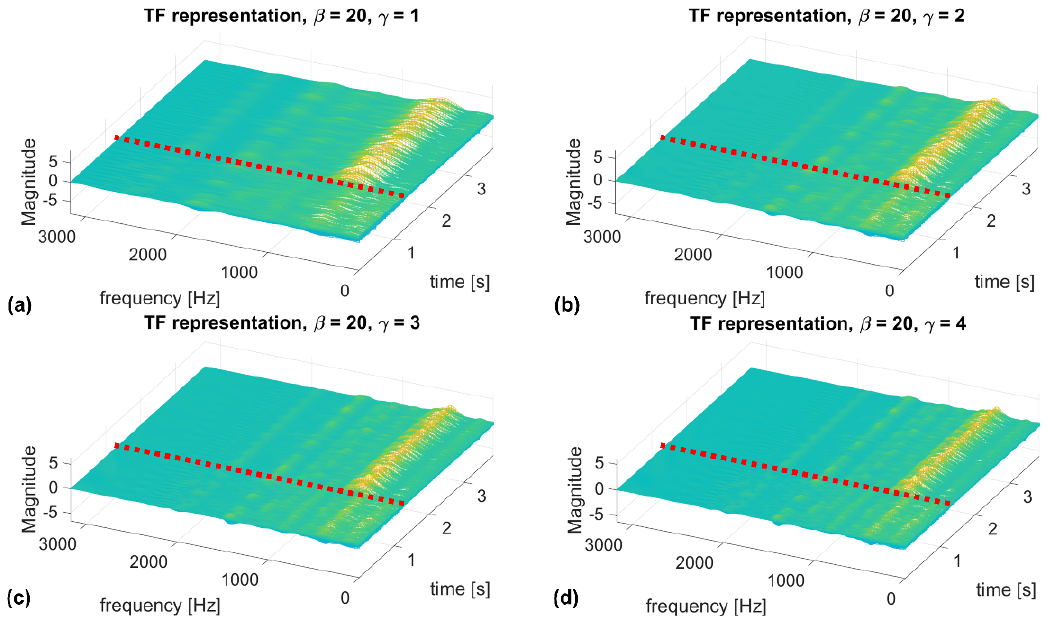
Figure 10. Time–frequency distributions corresponding to the results shown in Figure 9 ( 𝛽 = 20 and 𝛾 equal to ( a ) 1, ( b ) 2 , ( c ) 3 , and ( d ) 4.).